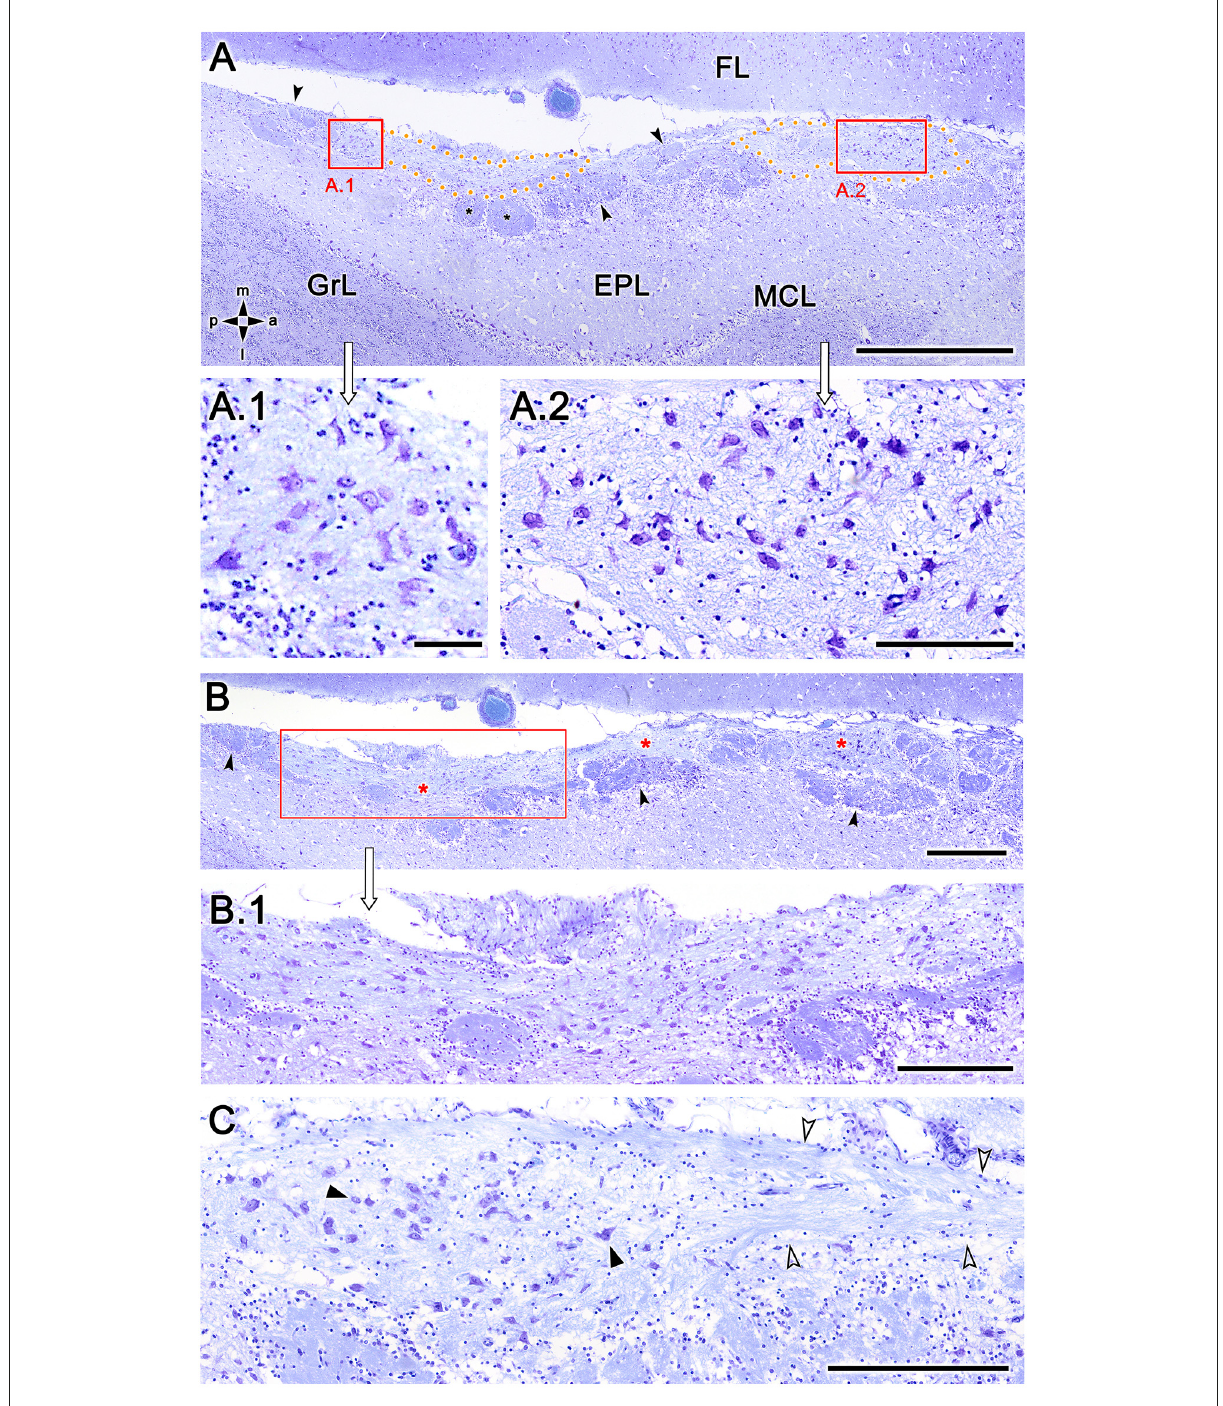
FIGURE4 Nissl-stained sections of the fox olfactory limbus (OL) at different horizontal levels. Serial Nissl-stained sections from a single specimen reveal the development of the OL in this species. (A) A neuronal cluster (box enlarged in A.1 ) and the superficial macroglomerular complex (MGC, encircled by yellow dots and partially enlarged in A.2 ) were observed in a section at the ventral level. Most glomeruli proximal to the MGC had irregular and atypical shapes (arrowheads), but some appeared spherical (black asterisk). (B) A more dorsal section shows the extent of the MGC (red asterisks). The red box is shown at a higher magnification in (B.1) . Atypical glomeruli were also observed (arrowheads). (C) An even more dorsal section shows the morphologies of MGC neurons (black arrowheads) and their association with a prominent fascicle of nerve fibers (open arrowheads). FL, frontal lobe of the telencephalon; GrL, granular layer; EPL, external plexiform layer; MCL, mitral cell layer. Orientation: m, medial; l, lateral; p, posterior; a, anterior. Scale bars: (A) : 1 mm. (B) : 500 µ m. (A.2,B.1,C) : 250 µ m. (A.1) : 100 µ